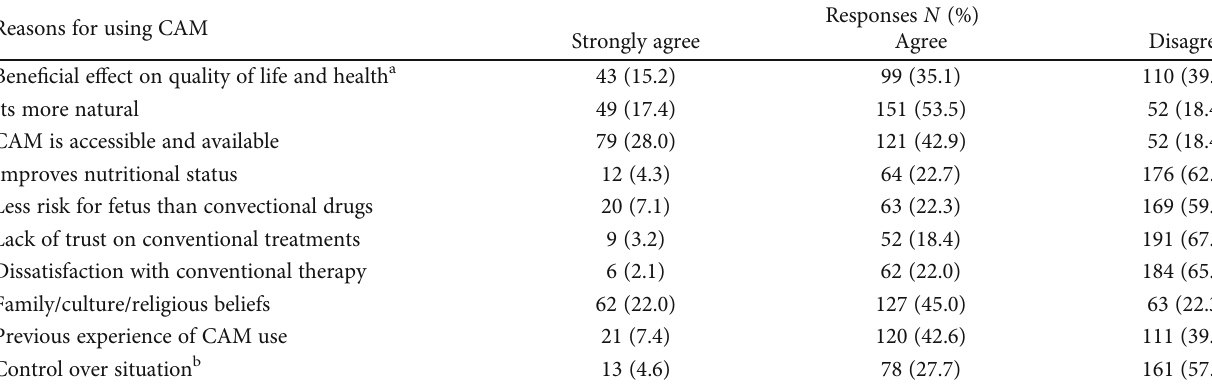
Table 3: Reasons for using CAM † in pregnancy ( N = 252 ).